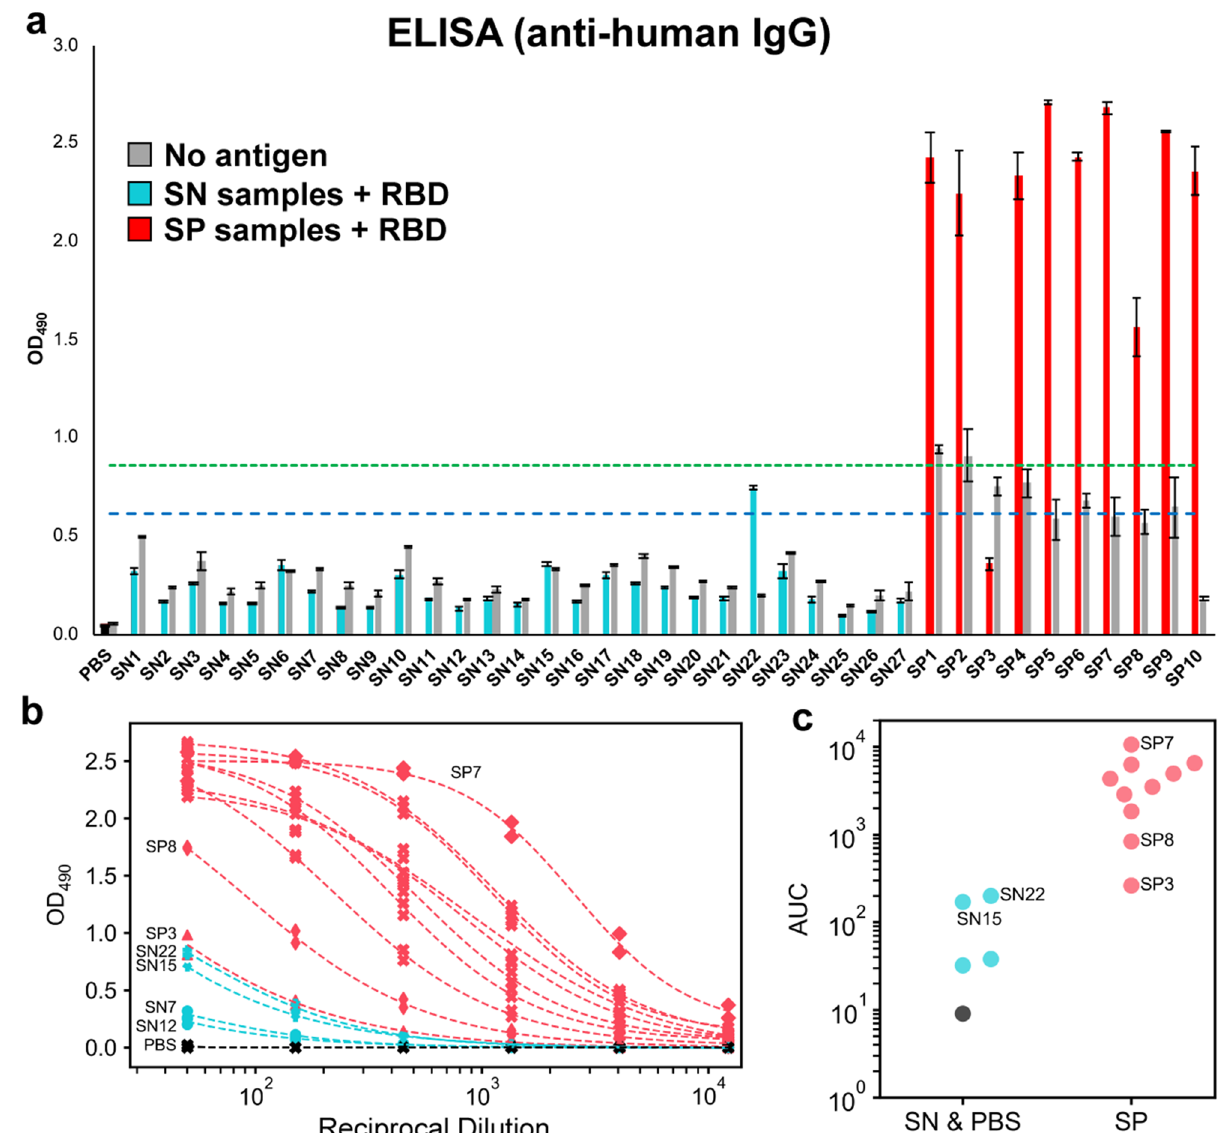
(SN, cyan) and convalescent seropositive (SP, red) samples compared to no-antigen controls (grey). The assays were performed with plasma at a 1:50 dilution. Samples were evaluated in biological duplicates and error bars represent one standard deviation from the mean. Blue and green dashed lines represent the mean of seronegative samples plus 3 and 5 standard deviations, respectively. ( b ) Dilution series ELISA was performed to quantitate RBD-reactive human IgG in plasma. Samples were evaluated in biological duplicates. Dashed curves represent fit lines from a four-parameter logistic regression applied over each series. ( c ) Data from ( b ) plotted as area-under-the-curve